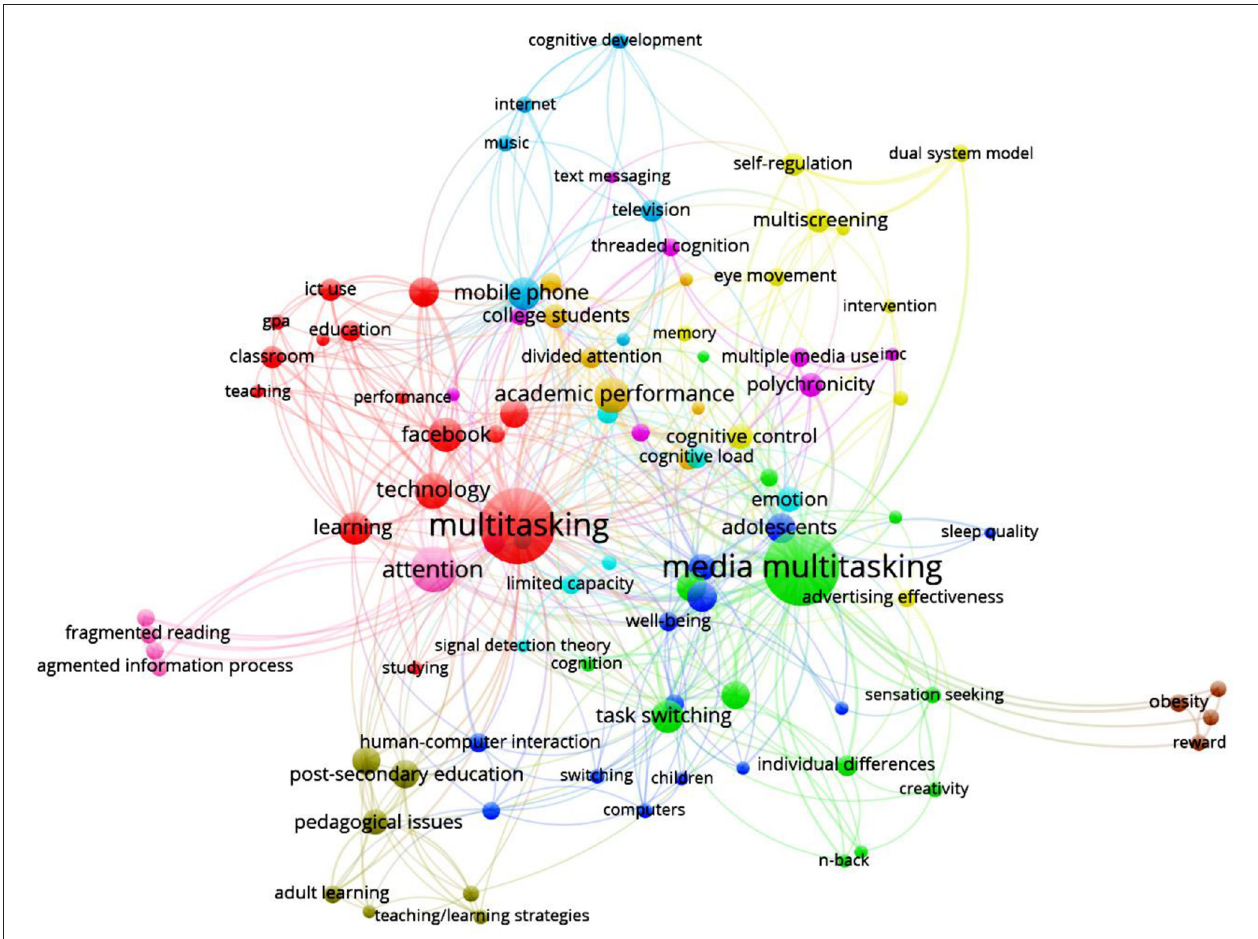
FIGURE 3 | The visualization of co-word